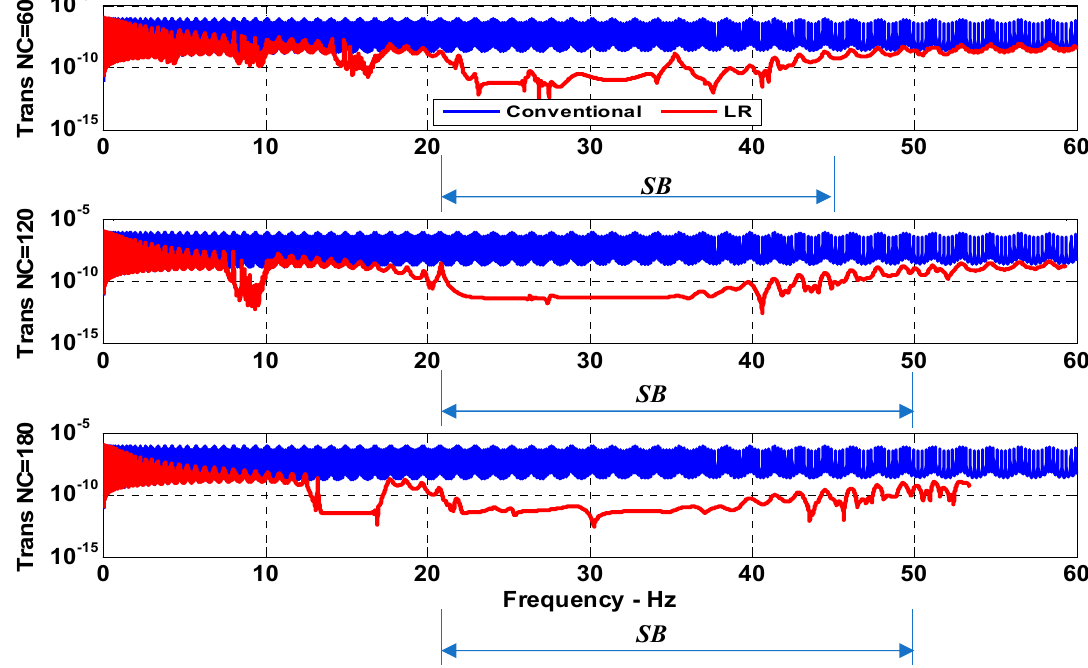
Figure 13. Comparisons between the transverse frequency response characteristics of a conventional drill-string and a